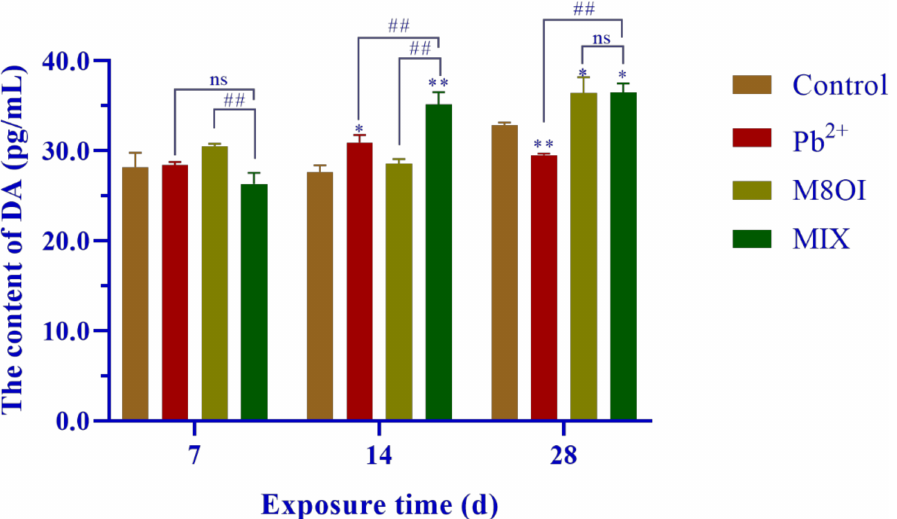
Figure 2. Effects of the combined exposure to Pb 2+ and the ionic liquid M8OI on the neurotransmitter dopamine levels in fish brains. Data are represented as mean ± SEM. * p <0.05 and ** p < 0.01 are expressing the difference levels between control and exposure groups. ## p < 0.01 is expressing the difference levels of between co-exposure and single exposure groups, and “ns” represents not